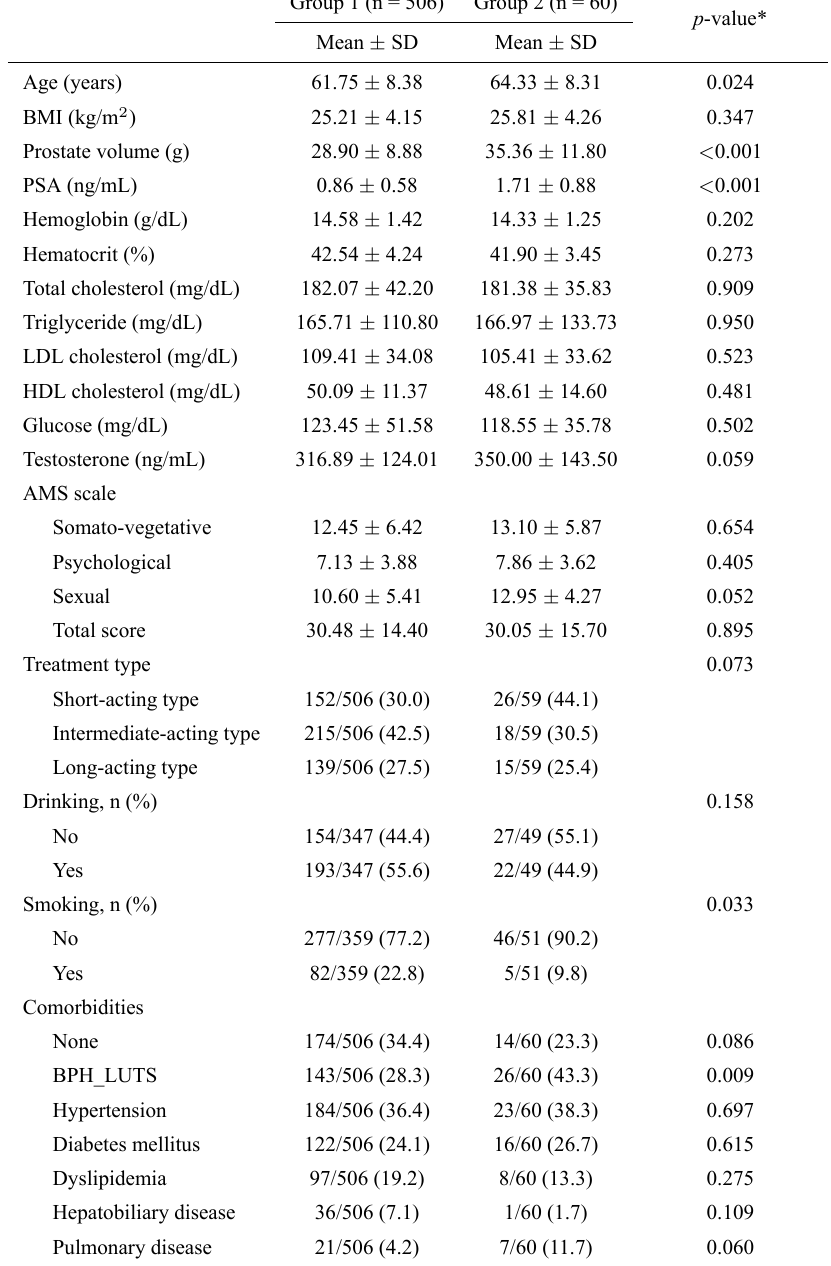
Table 1. Comparative medical and demographic characteristics of the patients in the PSA elevation group ( > 3 ng/mL) during testosterone treatment (Group 2) compared with those of patients in the non-elevation group (Group